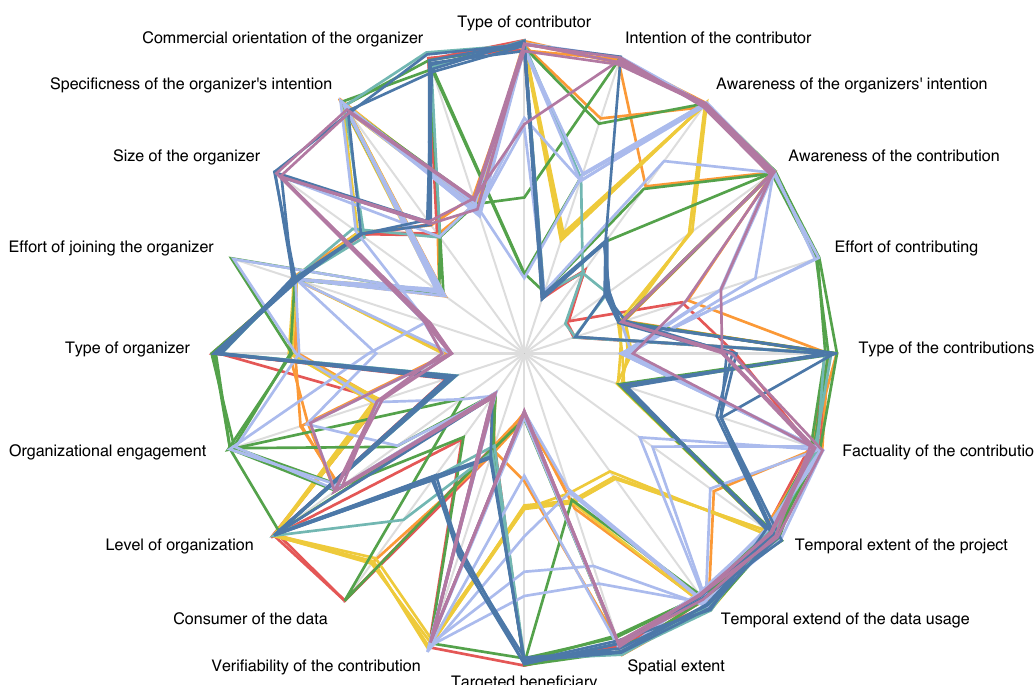
Figure 4. Spider chart of Geographical Shared Data Sources (GSDSs), showing the different dimensions in detail. The data has been slightly randomized. The legend for the categories can be found in Figure